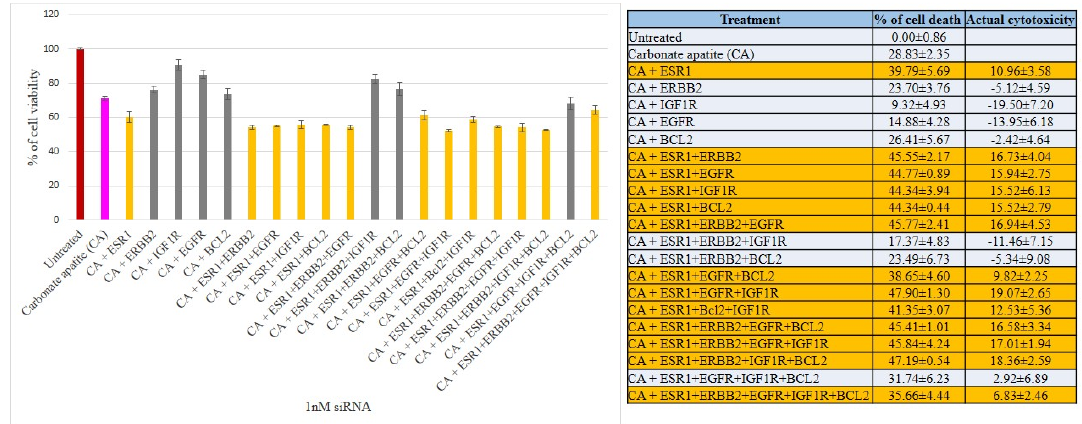
Figure 3. Cell viability and cytotoxicity assessments of MCF ‐ 7 cells treated with various CA ‐ siRNA complexes involving ESR1, ERBB2, IGF1R, EGFR and BCL2 siRNAs (1 nM) individually or in combination, for a period of 48 h. Preparation of the CA ‐ siRNA(s) complexes involved introduction of ESR1, ERBB2, IGF1R, EGFR and BCL2 siRNAs individually or in combination with 3.5 mM of CaCl 2 to 1 mL of bicarbonate ‐ buffered DMEM (pH 7.4). The mixture was allowed incubation at 37 °C for 30 min before the addition of 10% FBS. The cells were incubated for the next 48 h with the prepared complexes. MTT assay was performed and absorbance reading was taken at 595 nm with 630 nm as references wavelength. Data was presented as mean ± SD of triplicates.